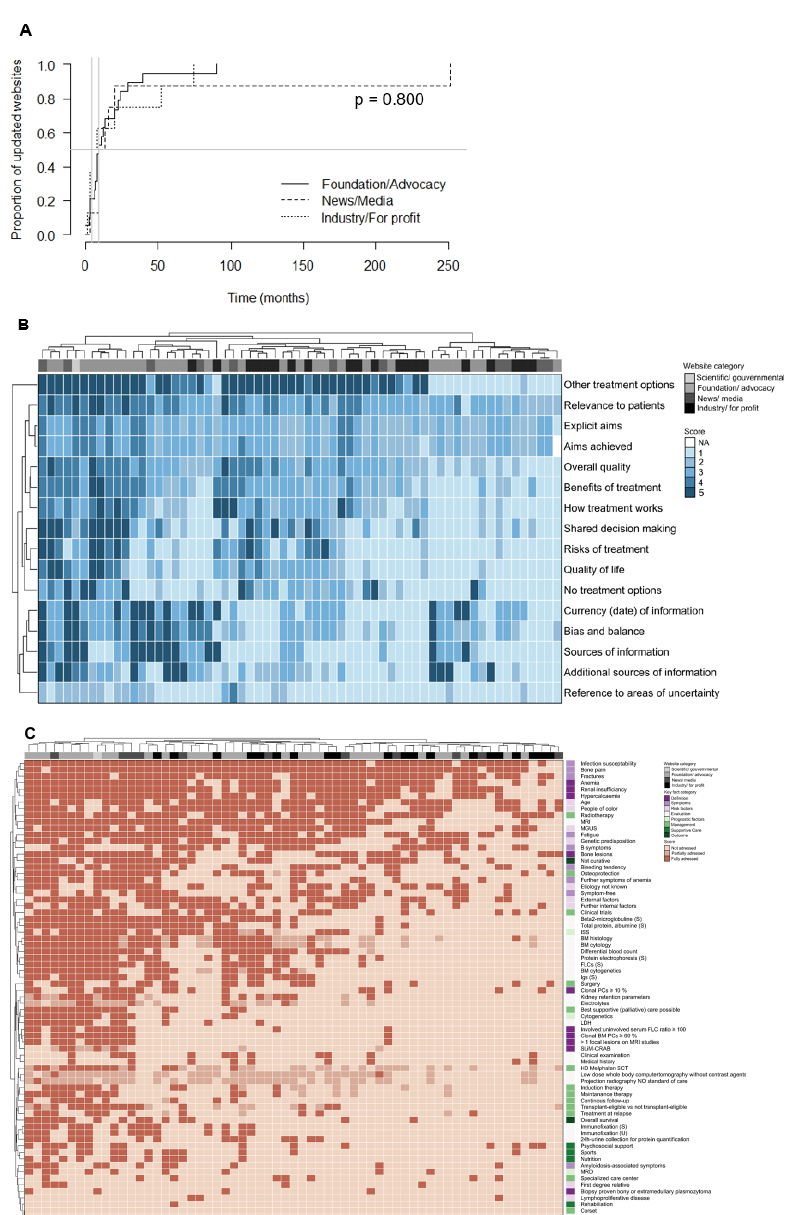
Figure 2. Characterization of websites by category. ( A ) Inverse Kaplan-Meier curves show the proportion of website updates by time and website category. Only websites with an indicated update date were included (foundation/advocacy n = 19, news/media n = 8, industry/for profit n = 8). The available scientific/governmental website ( n = 1) was excluded from the analysis. ( B ) Unsupervised hierarchical clustering was performed by DISCERN score items (rows) and single websites (columns, n = 63). Item 2. “aims achieved” displays not assessable (NA) scores, as it was only assessable if item 1. “explicit aims” was not scored with 1. The website category is shown in the top row of the heatmap. Websites provided by foundations/advocacies cluster on the left side of the heat map, indicating a higher number of addressed DISCERN score items. ( C ) Unsupervised hierarchical clustering was performed by key fact score items (rows) and single websites (columns, n = 63). The website category is shown in the top row and the key fact item category is in the last column of the heatmap. Websites provided by foundations/advocacies cluster on the left side of the heat map, indicating a higher number of addressed key